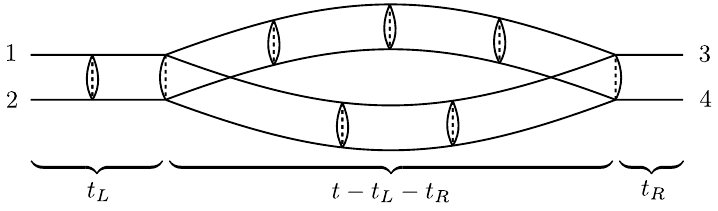
Figure 2. An SYK diagram contributing to the OTOC at late times, such that λ ∼ 1